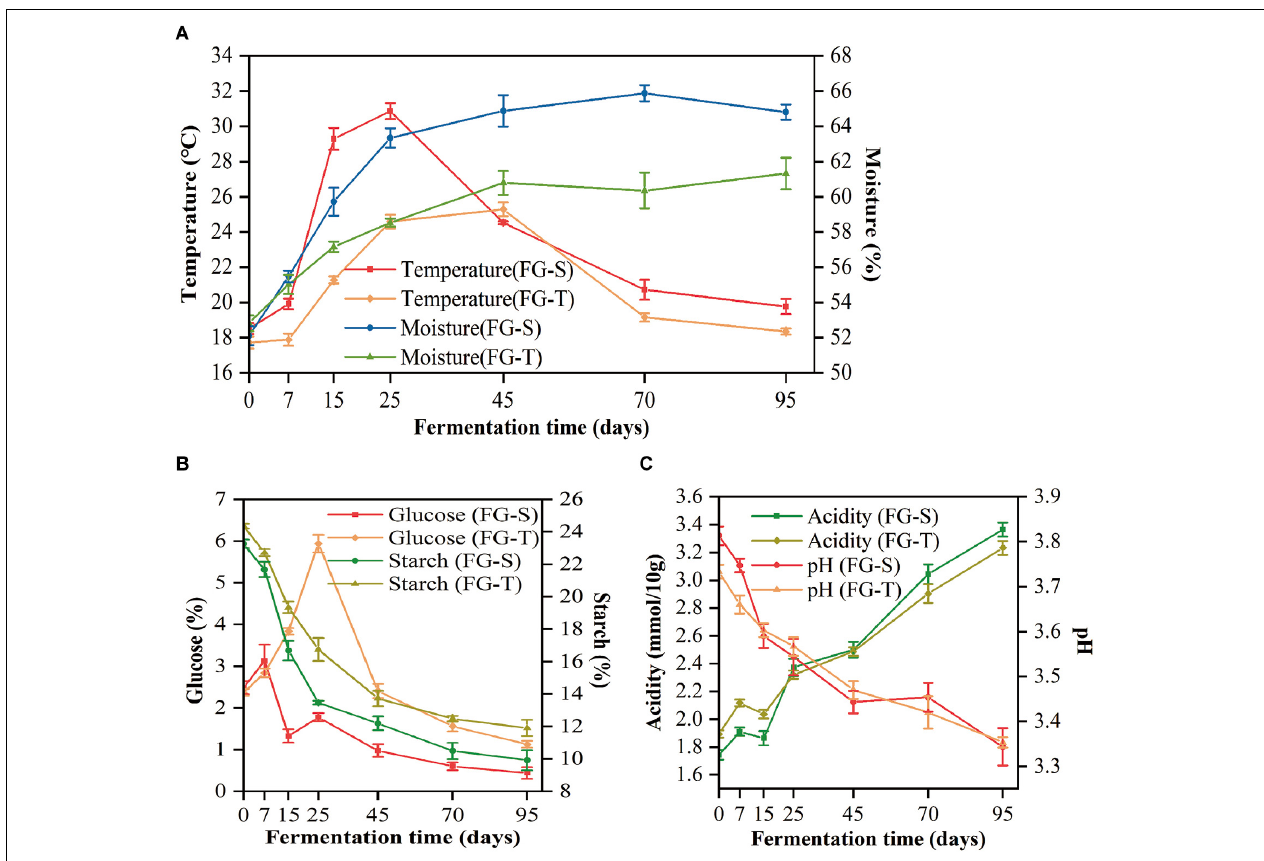
FIGURE 1 | Dynamics of physicochemical characteristics during the SCSSF and TCSSF processes. (A) Changes in core temperature and moisture of fermentation grains. (B) Changes in reducing sugar (calculated as glucose) and starch contents. (C) Changes in pH and titratable acidity.